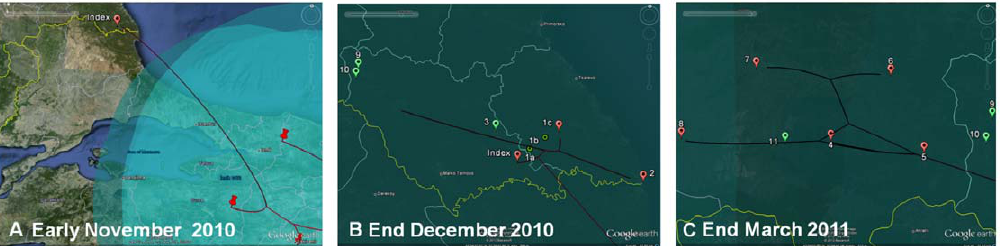
Figure 5. Spatiotemporal dynamics of the FMDV epidemic in Bulgarian 2011. The simplest option was considered for the selection of the gamma-random-relaxed-walk (RRW) continuous diffusion model. The isolate from Israel was excluded from this analysis,. Satellite imagery: GoogleEarth. Date accessed: 25 May 2012. Co-ordinates: 40 u 57 9 25.89 0 N, 28 u 27 9 28.38 0 E (A); 42 u 04 9 27.07 0 N, 27 u 39 9 47.60 0 E (B) 42 u 09 9 01.30 0 N, 27 u 09 9 42.18 0 E (C). A . FMDV spread from the North-West of Turkey throughout Bursa (Anatolia, Turkey) to Brugas (Bulgaria). The uncertainity on the location the virus is represented by transparent polygons (80% HPD). Turkish Thrace might have been infected before November 2010, which is plausible with the serological results in wild boar. B . The transmission infection pathways between the wild boar, outbreaks 1, 2, 3 and the second wave of outbreaks is not clarified. It might be explained by un-sampled notified sites/outbreaks or by a reservoir in wildlife (i.e. wild boar), both hypotheses are compatible with a genetically and spatiotemporally close FMDV replicating within a host. C . The genetic spatiotemporal reconstruction of the second wave of outbreaks linked them to each other, in agreement with epidemiological data, i.e. owners from animals in outbreak 6 had animals in the location of outbreak 4.